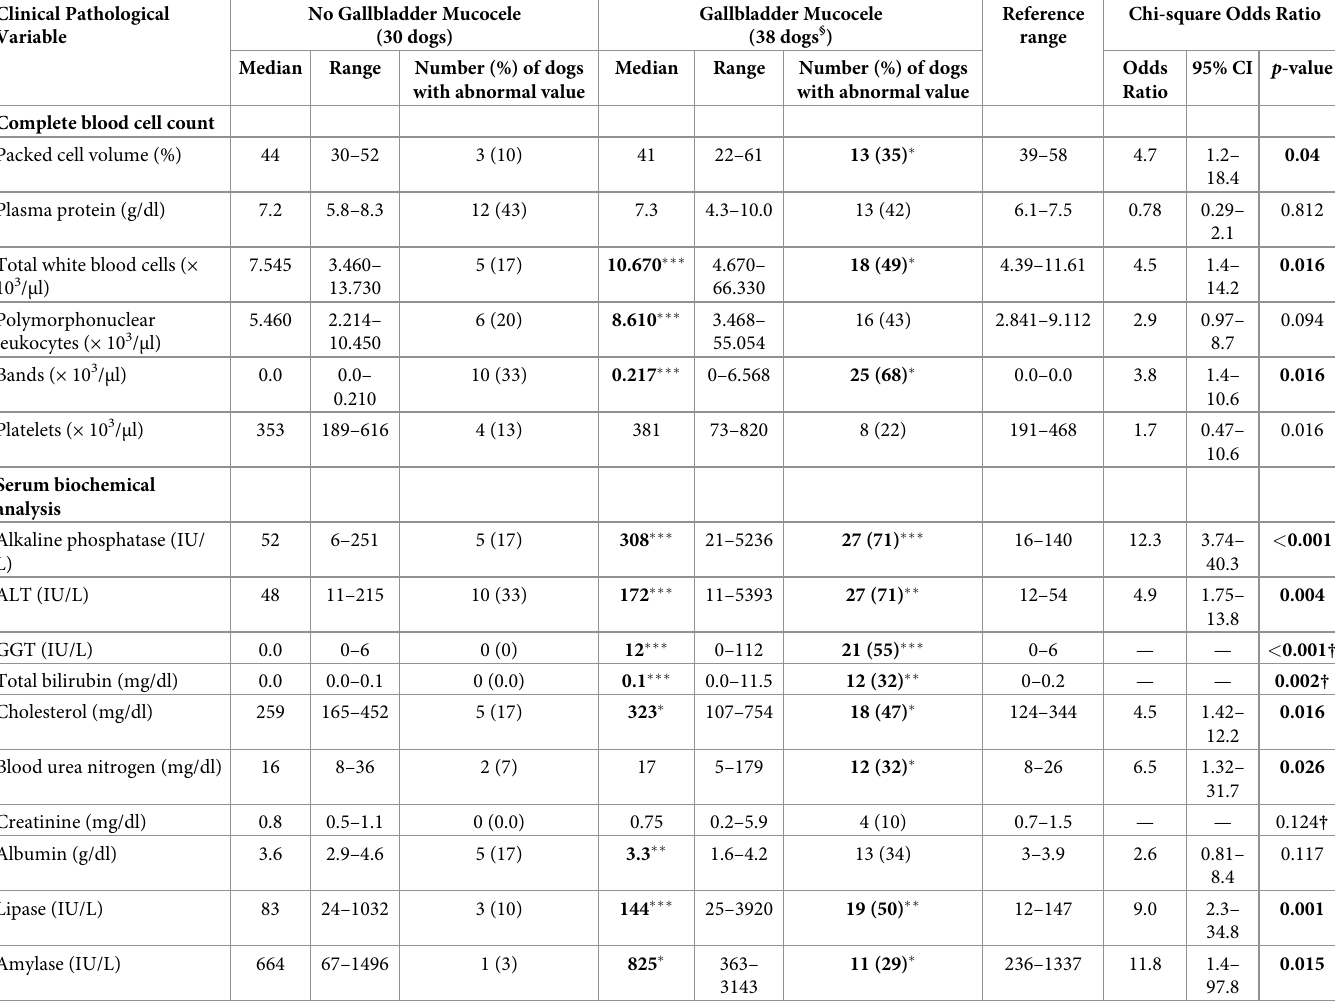
Comparison of median values performed using Kruskal-Wallis One Way ANOVA on Ranks. Comparison of proportions performed using Chi-square statistic. � p < 0.05 �� p < 0.01,